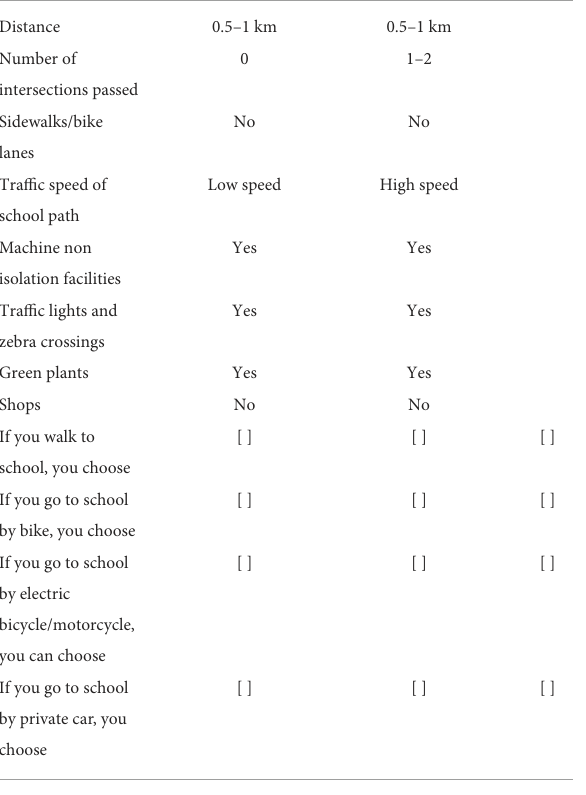
TABLE 2 An example of a stated choice set for children.